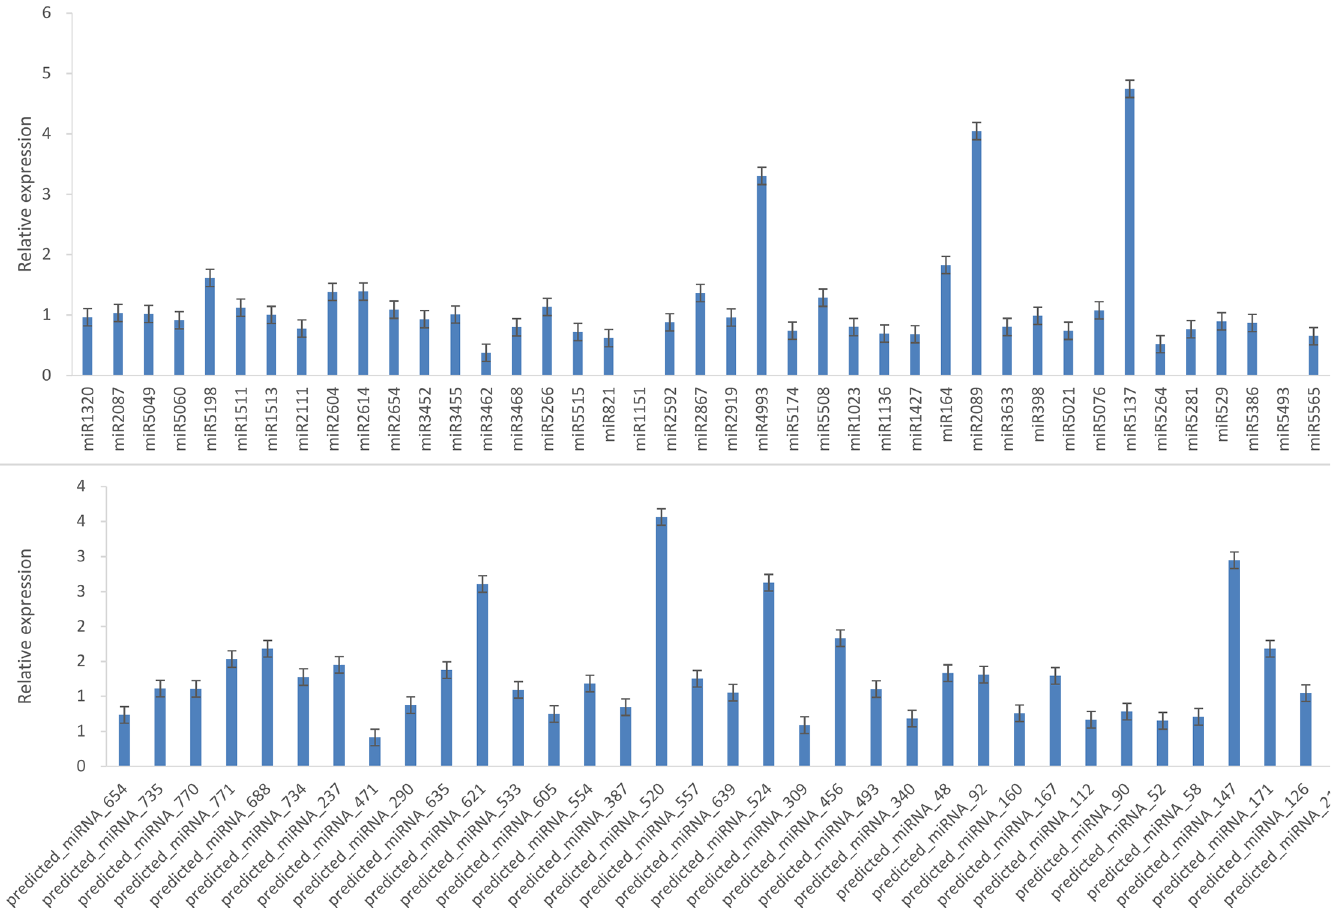
Fig 4. Expression analysis of miRNAs in both wild and mutant strains by qRT-PCR. The expression levels of miRNAs were normalized to the reference gene 5S rRNA.